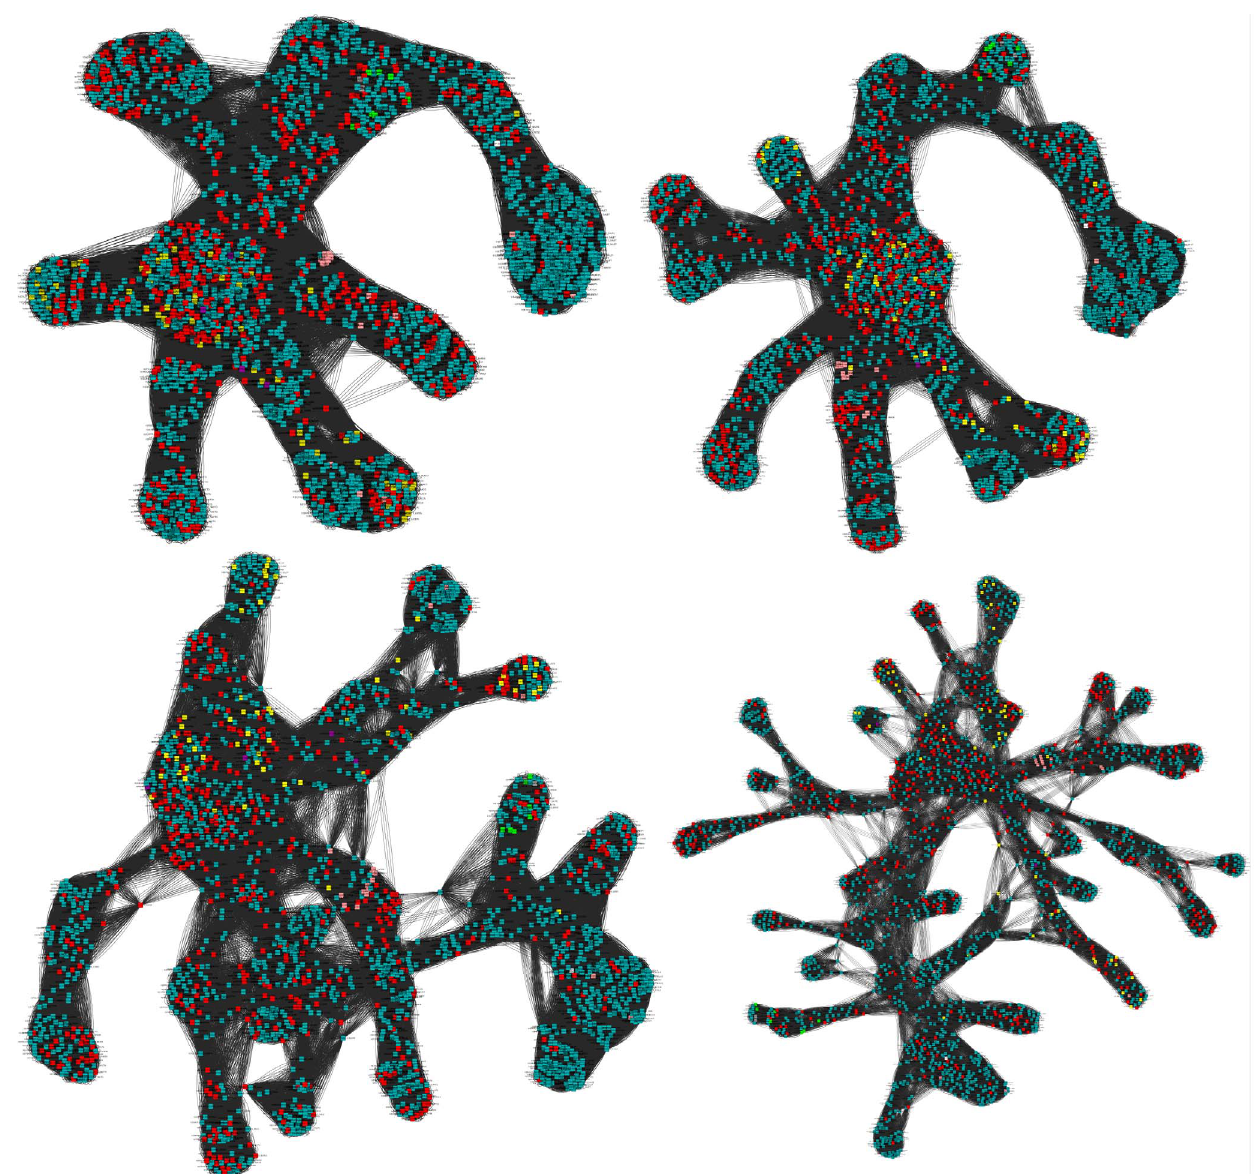
Figure 4. Variation of a protein similarity network as a function of DJPx threshold. An automatic search for E. coli protein YebC (PDB code 1KON) represented with Cytoscape organic layout and different maximum number of top edges per node (DJPx). Related proteins are found in UniProt database using the Pfam-A family PF01709. Edges are shown for pairwise sequence identity greater than 40% and alignment coverage at least 50%. From left to right and top to bottom, the networks shown the top 100 edges per node, 75, 50 and 25. In all cases, nodes sharing the Biological Process GO terms electronically assigned (IEA) to the query protein are colored in red.